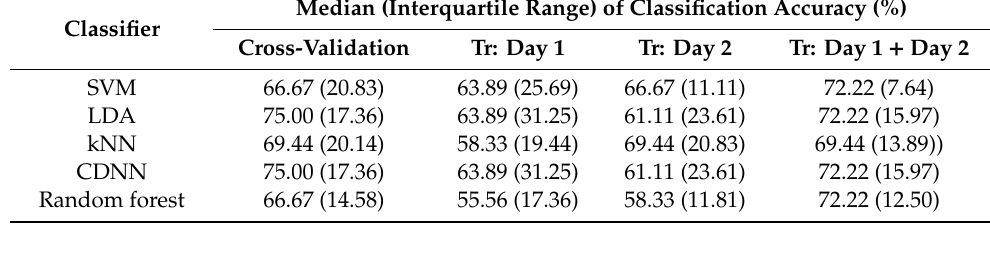
Table 3. Median and interquartile range of classification accuracies using various classifiers.